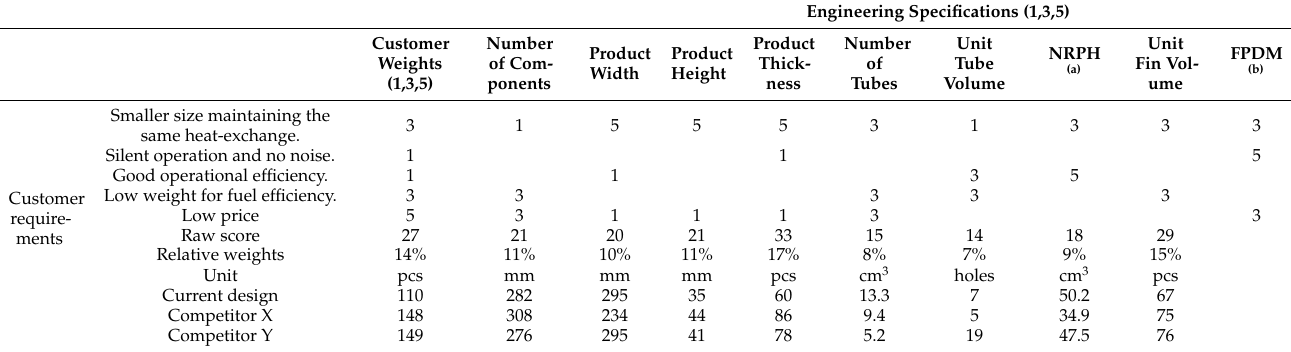
Table 2. Quality function deployment (QFD) for the air conditioning system (A/C system) evaporator.